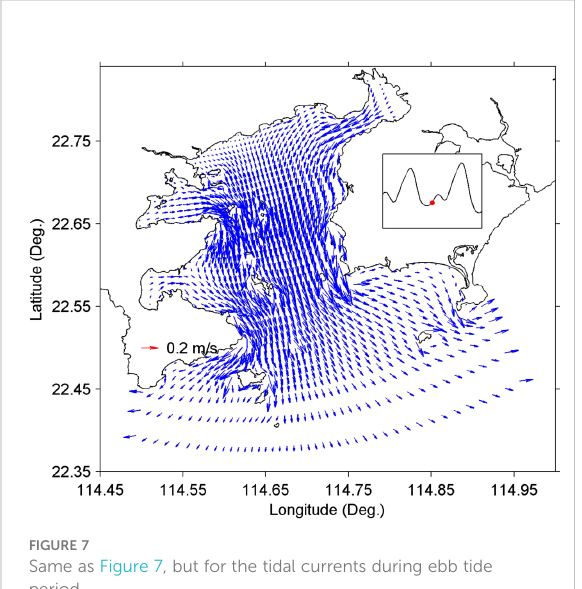
FIGURE 9 Model simulated summer mean bottom temperature distribution in the Daya